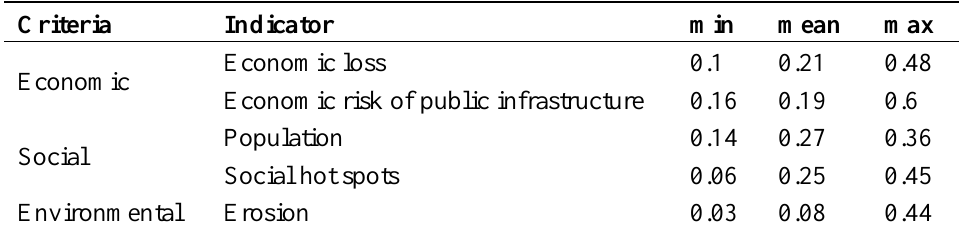
Table 5. Weight sets of